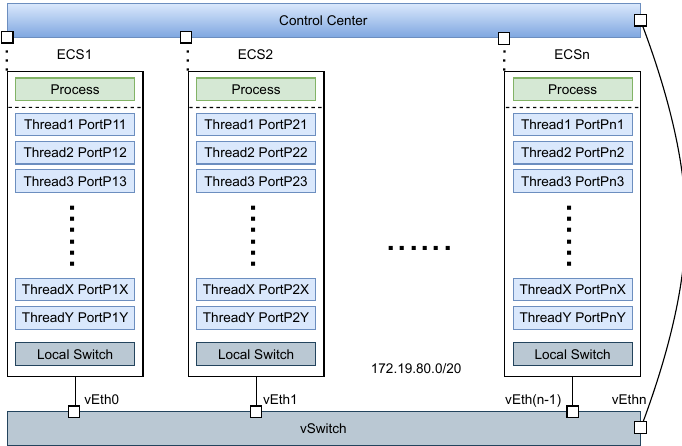
Figure 15. ECS experimental